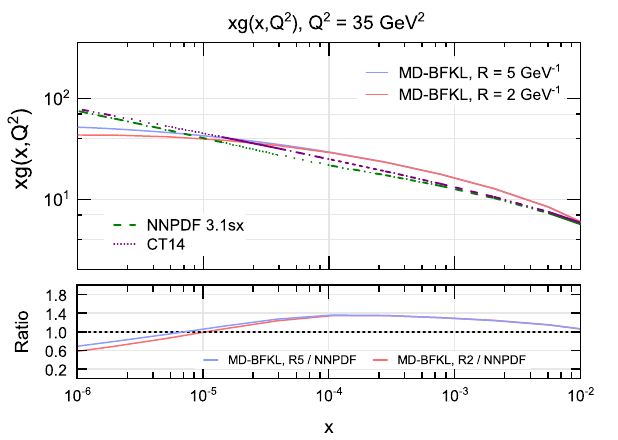
) . Our 2 GeV − 1 (at “hot-spots” within proton disk). Theoretical prediction T is compared with global datasets NNPDF 3.1sx and CT 14